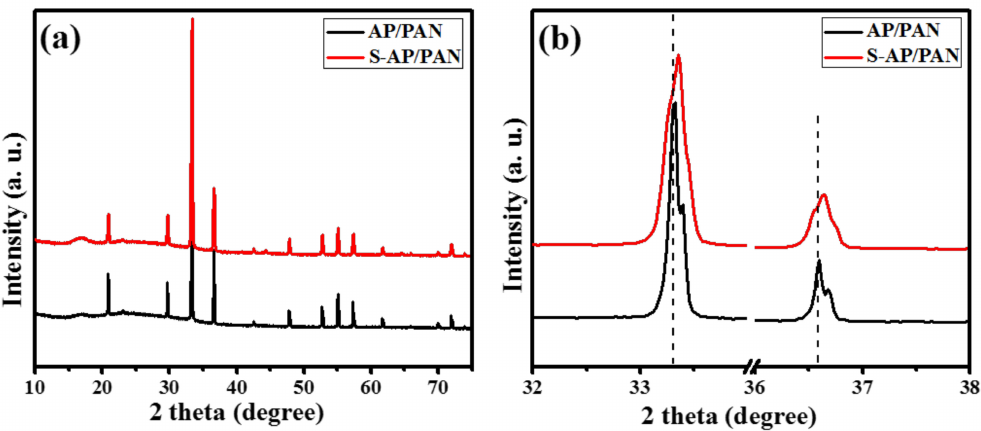
Figure 1. ( a ) XRD di ff raction patterns; AP / PAN and S-AP / PAN and ( b ) magnified peaks of (210) and (211) crystal